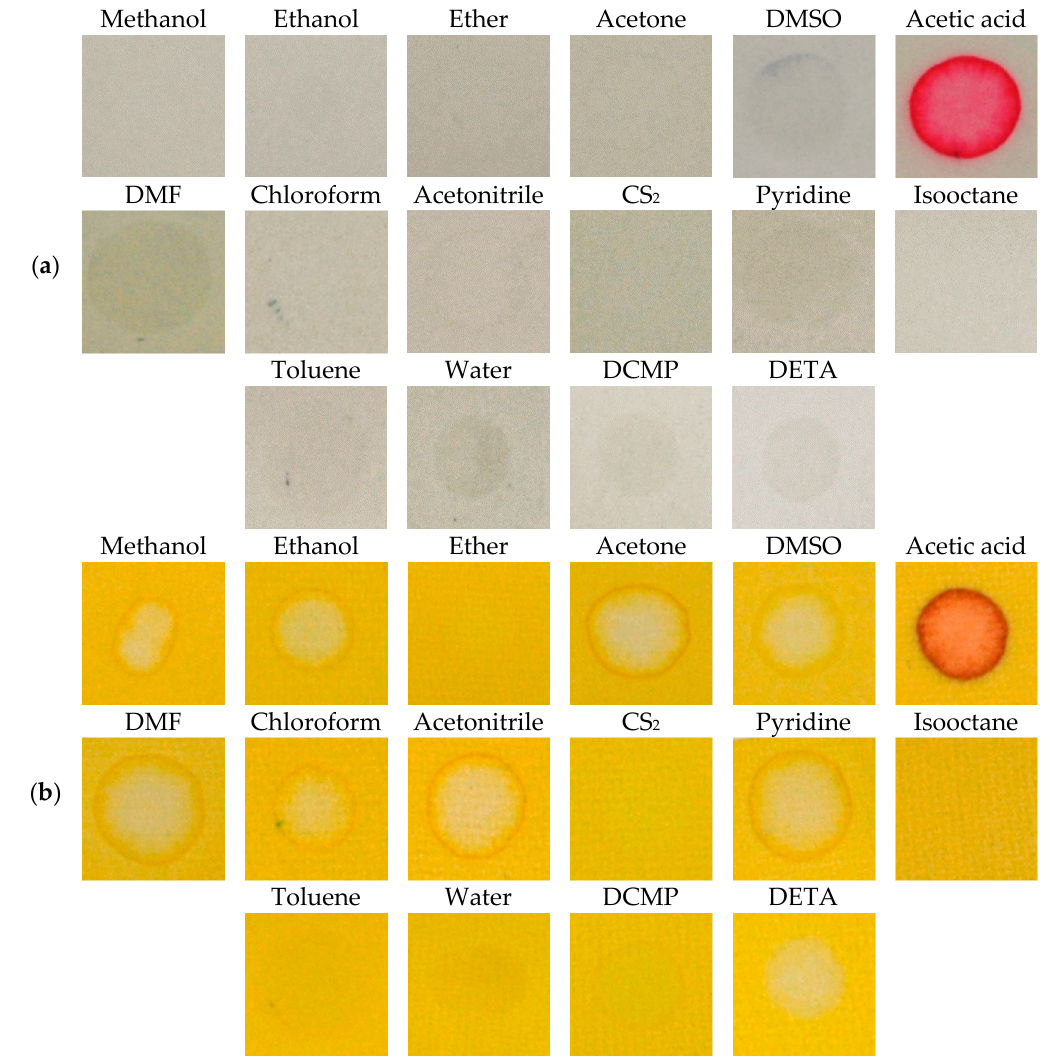
Figure 10. Color response ( a ) RM1a, ( b ) RM1a/PY-OPD to selected chemicals (DMSO—dimethyl sulfoxide, DMF—dimethylformamide, DCMP diethyl cyanomethylphosphonate, DETA—diethylenetriamine).